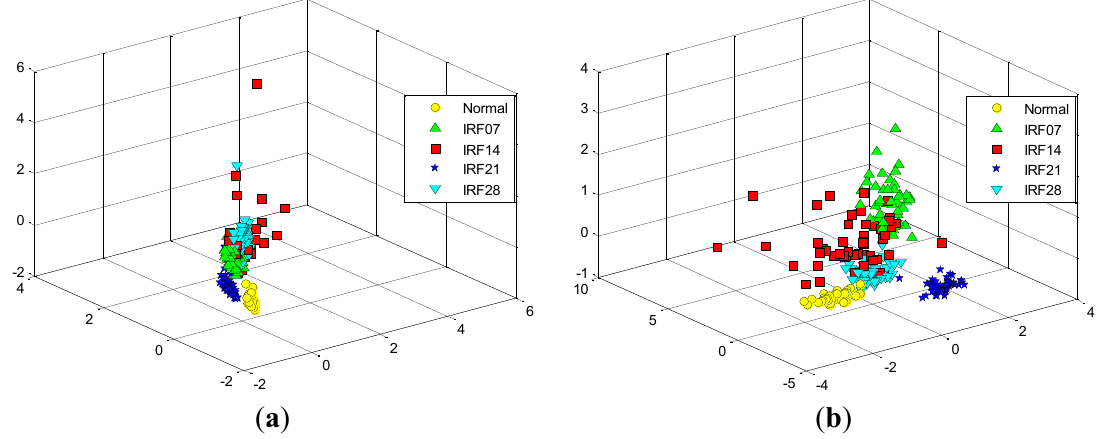
Figure 12. The randomly selected three features from the total 29 features in the D_IRF dataset: ( a ) the first selection. ( b ) the second